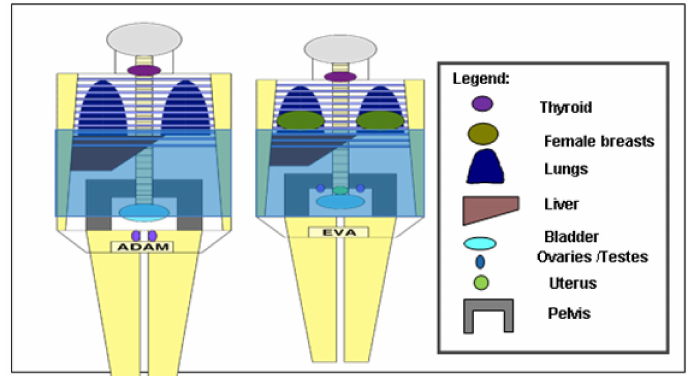
Figure 1. CT-Expo scan range for adults; all organs doses HT are based on conversion coefficients for adult standard patients (AdAM,